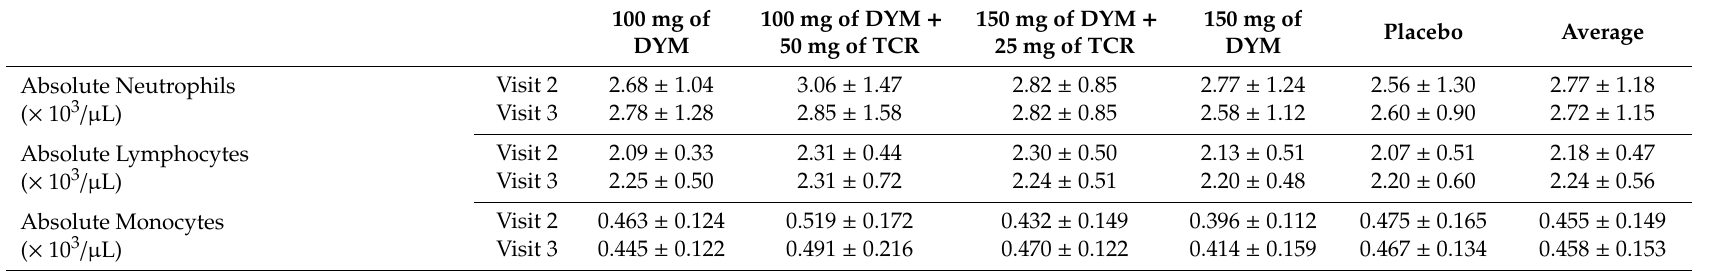
Table 4. Group ( n = 25 per group) and average complete blood count comparisons between Visits 2 and